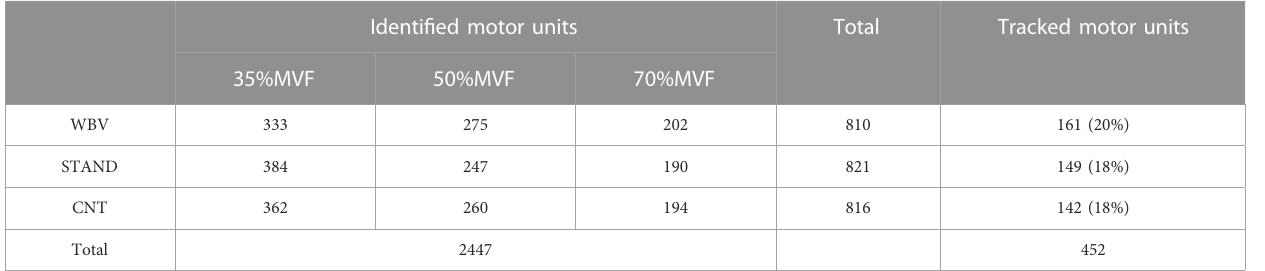
TABLE 1 Number of identi fi ed and tracked motor